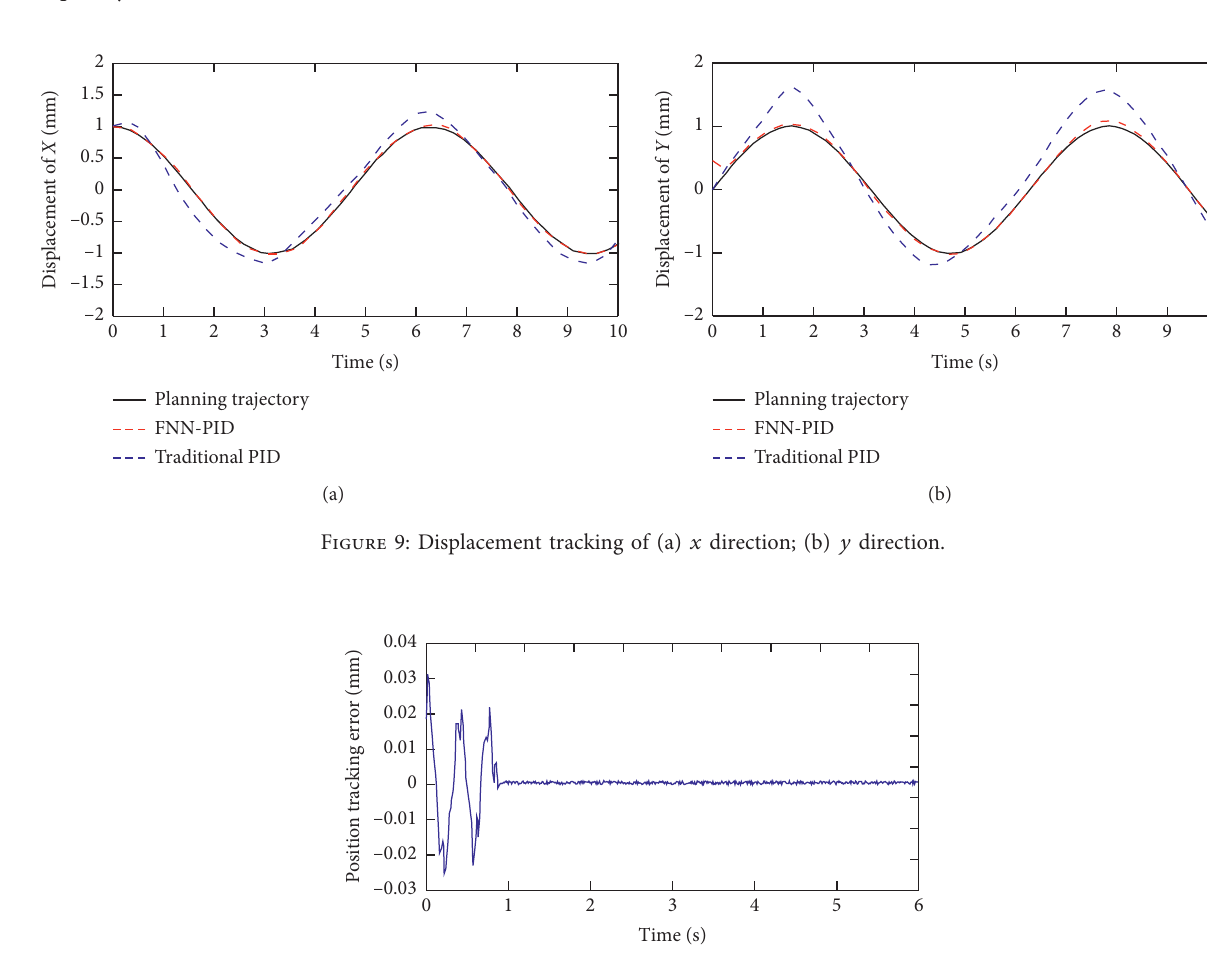
Figure 10: Position tracking errors of the end-effector of two-link robotic manipulator.